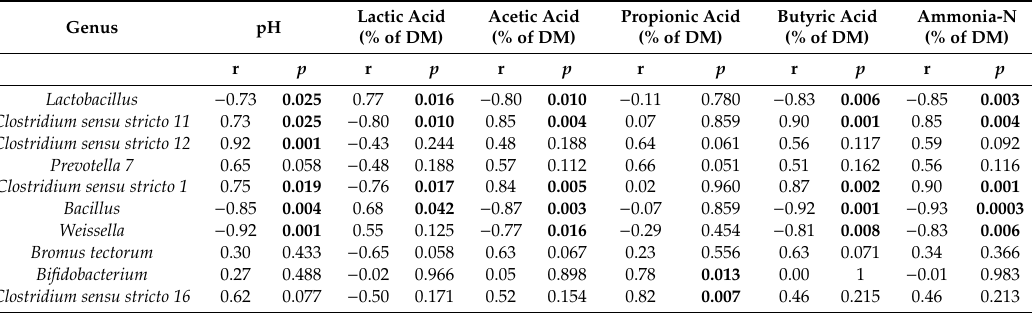
Table 4. Pearson correlation coe ffi cients between the abundance of bacterial genera and fermentation indices of wet brewers grains ensiled for 20 days. Genus pH